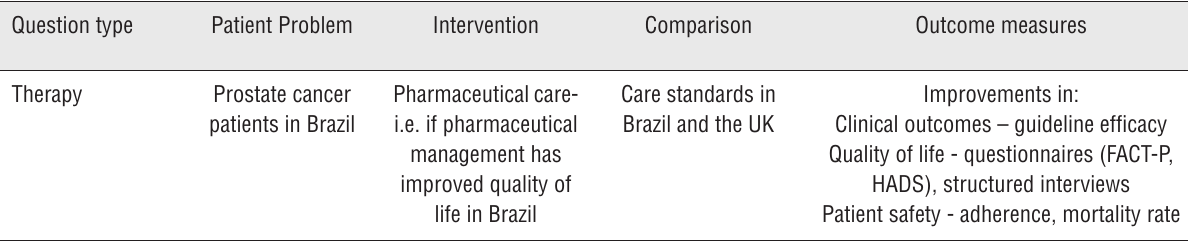
Table 1 - PICO framework of study inclusion.